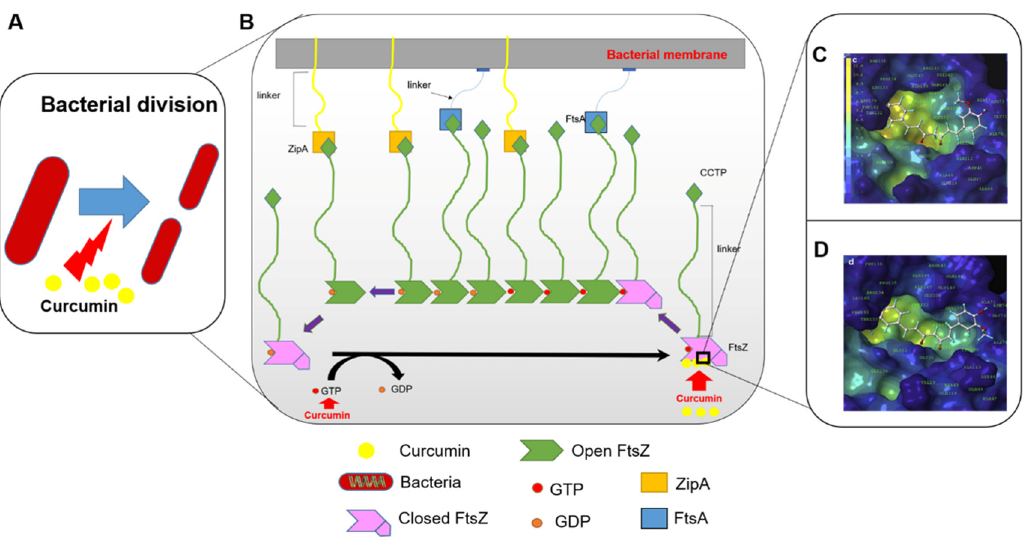
Figure 4. Curcumin inhibits the bacterial division by blocking FtsZ assembly. ( A ), working model of curcumin for the inhibition of bacterial division. ( B ), curcumin can activate the activity of GTP and interact with FtsZ, blocking the FtsZ assembly [65]. ( C , D ), the interaction site of FtsZ with curcumin in E. coli and B. subtilis strains, respectively